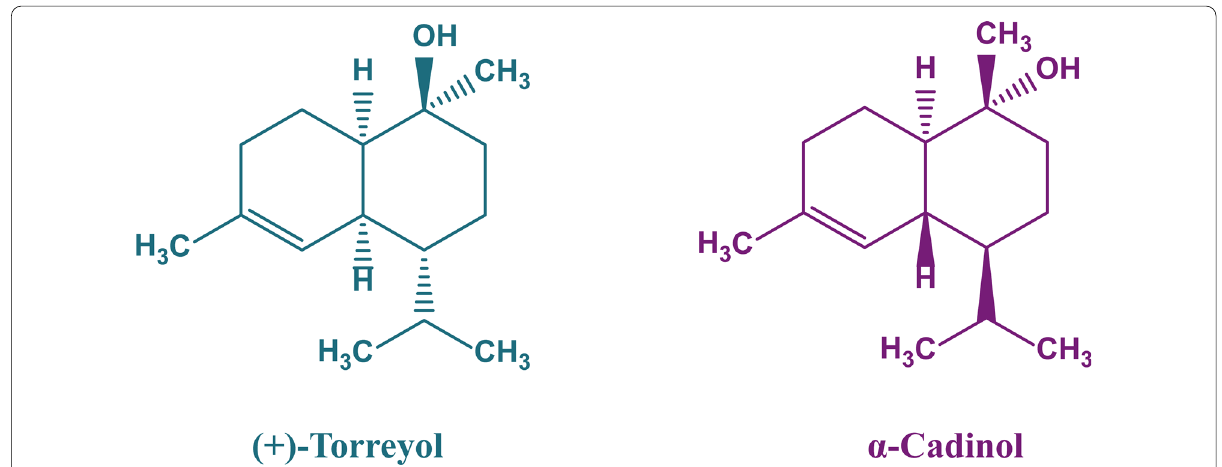
Fig. 2 Chemical structures of two cytotoxic sesquiterpene products from L.